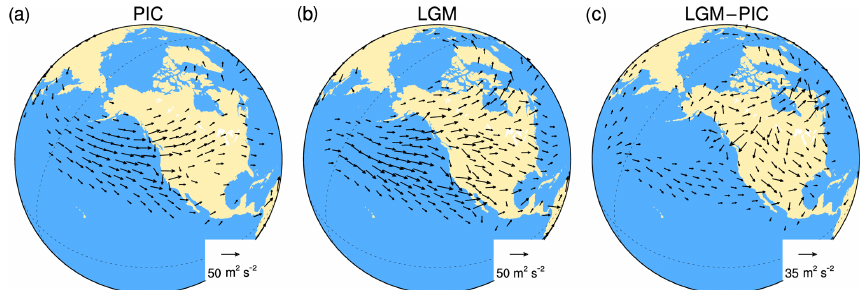
Figure 4. Stationary wave activity fluxes in PMIP2 CCSM3 simulations at 500hPa. (a) PIC, (b) LGM and (c) LGM–PIC. Length scales of wave activity vectors are marked in plots. Wave activity vectors are plotted if their length scales are greater than 12m 2 s − 2 in plots (a) and (b) and greater than 6.5m 2 s − 2 in plot (c) . Here, stationary wave activity fluxes are calculated with monthly-mean